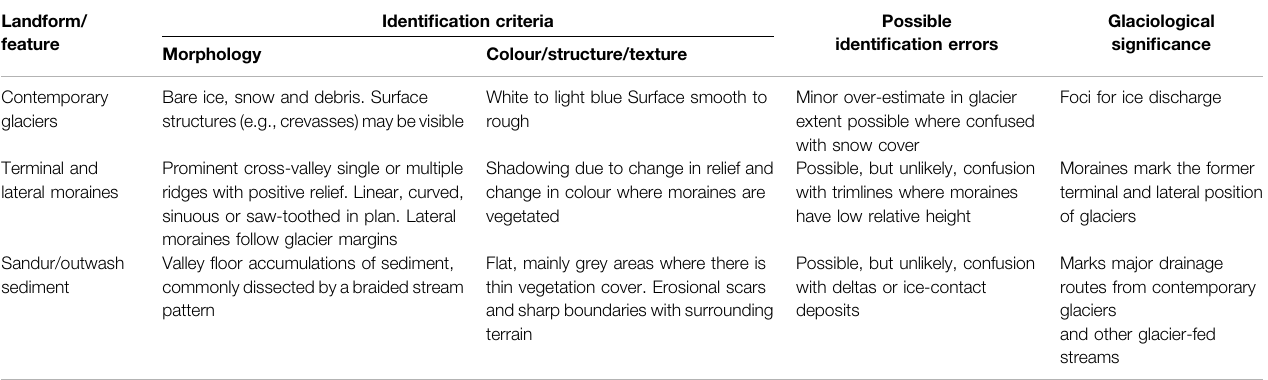
TABLE 4 | Criteria used in geomorphological mapping to identify ice-surface and proglacial landforms. Adapted from Glasser et al.